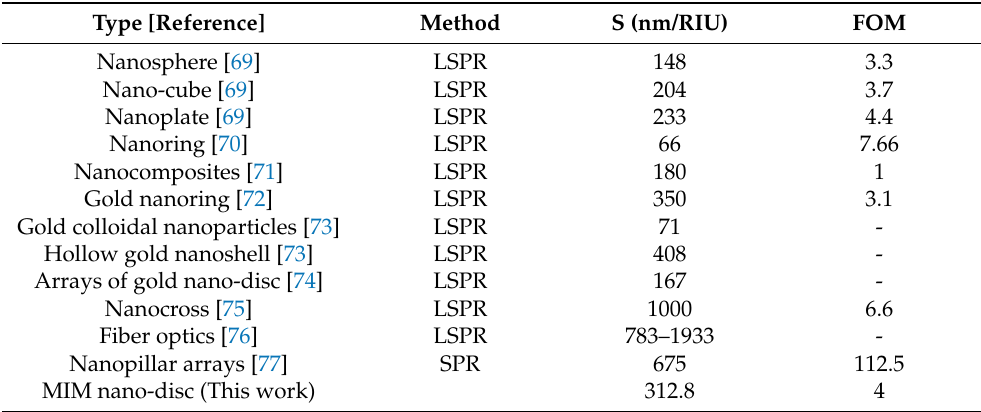
Table 2. Comparison of the sensitivity and FOM of reported in various plasmonic nanostructures with this